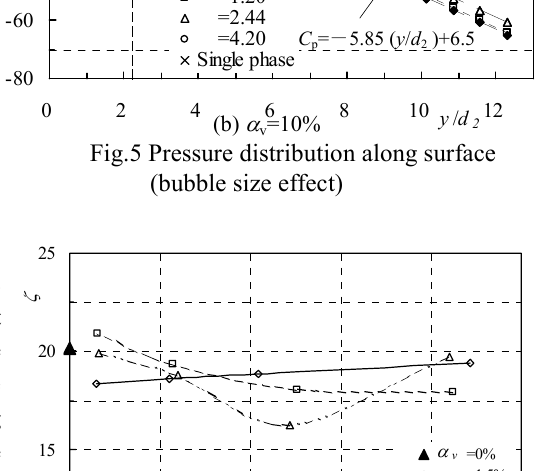
Fig.6 Bubble size effect on expansion loss coefficient